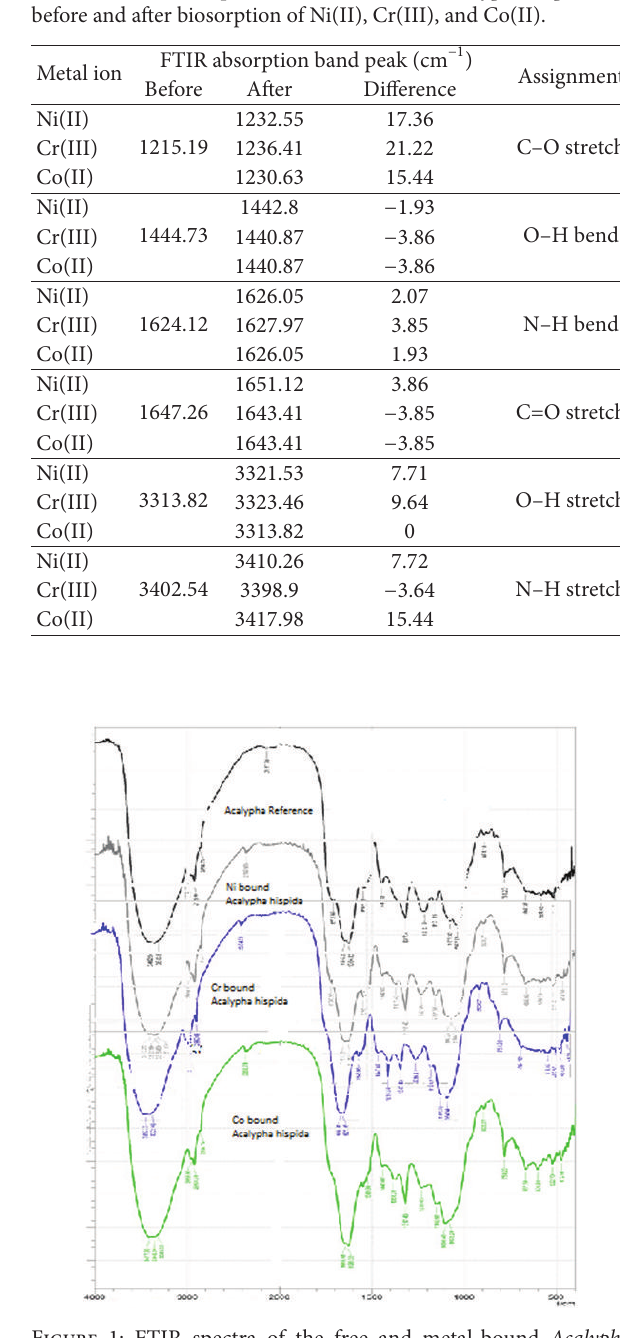
T 1: e FT-IR spectral characteristics of Acalypha hispida leaf